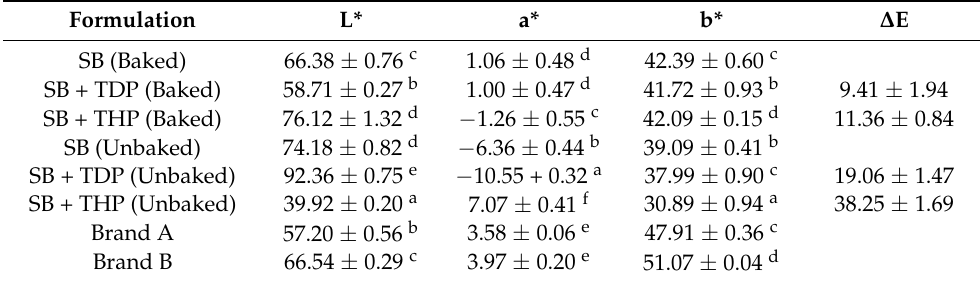
Table 3. Color analyses of snack bar products.